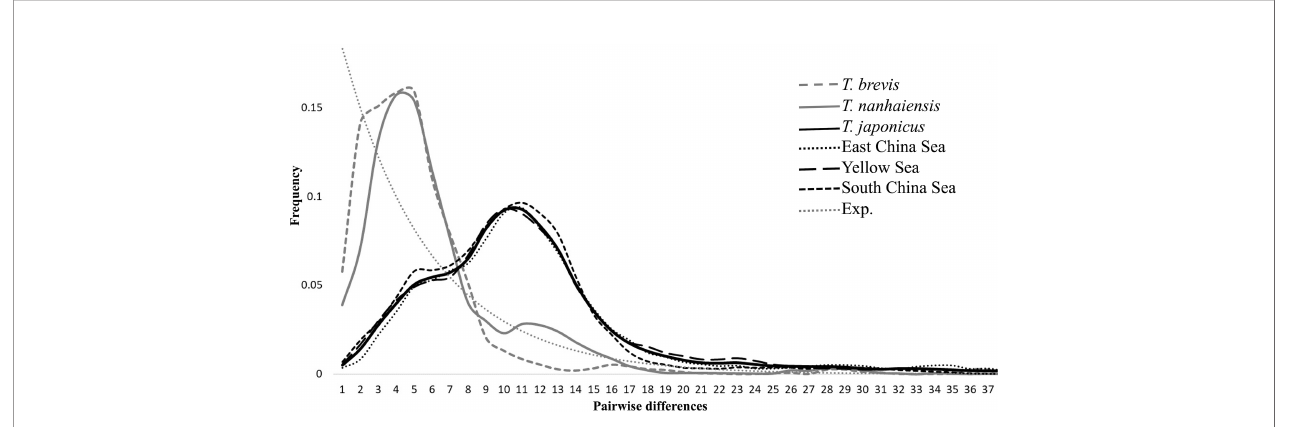
FIGURE 2 | Mismatched distributions of three Trishiurus species and three metapopulations (Yellow Sea, East China Sea, and South China Sea) of T. japonicus .